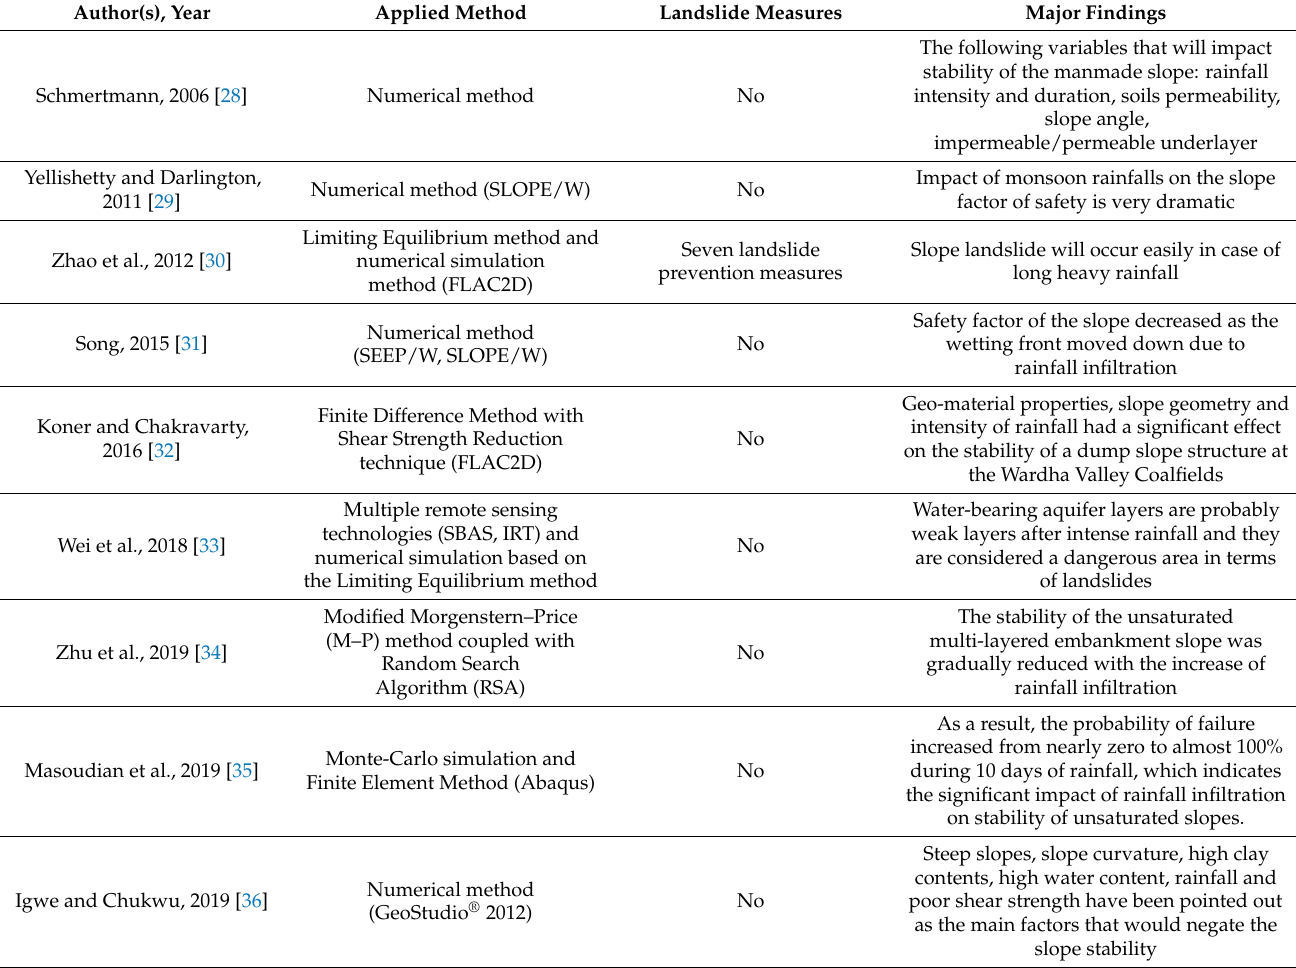
Table 1. Case studies on the impact of rainfall on the mine waste dump